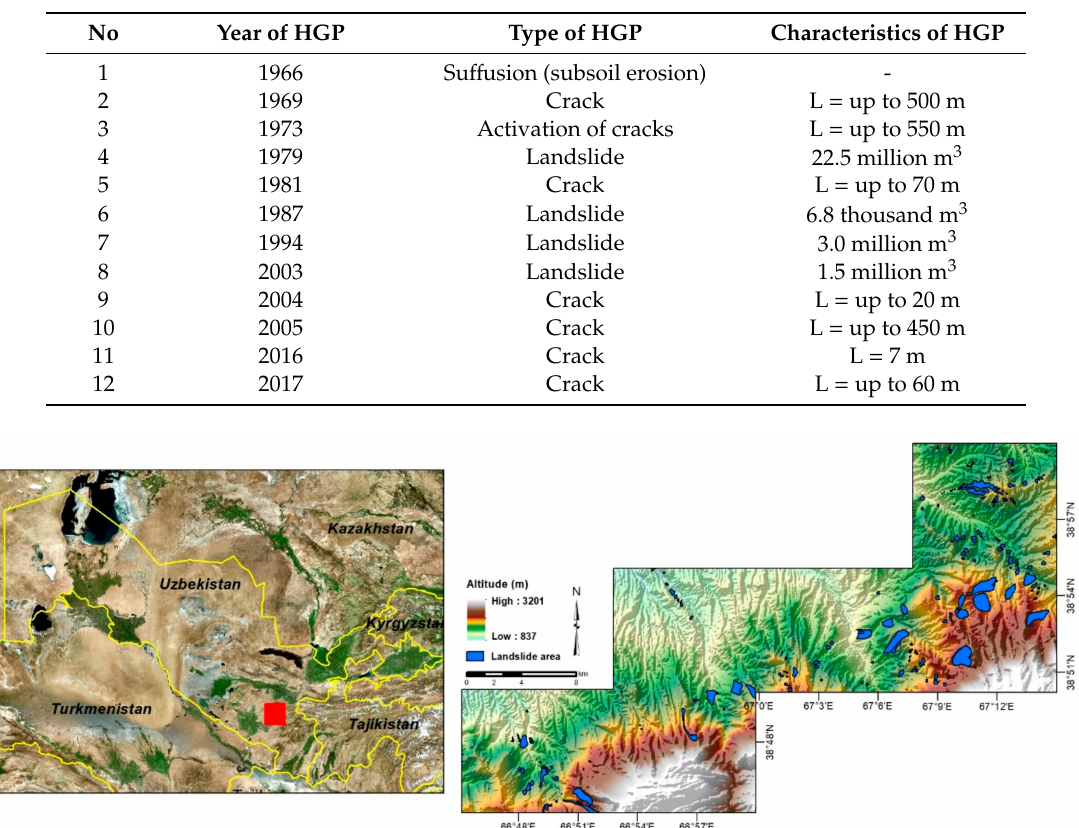
Table 2. Hazardous geological processes (HGP) documented in the Tekstilsik area.